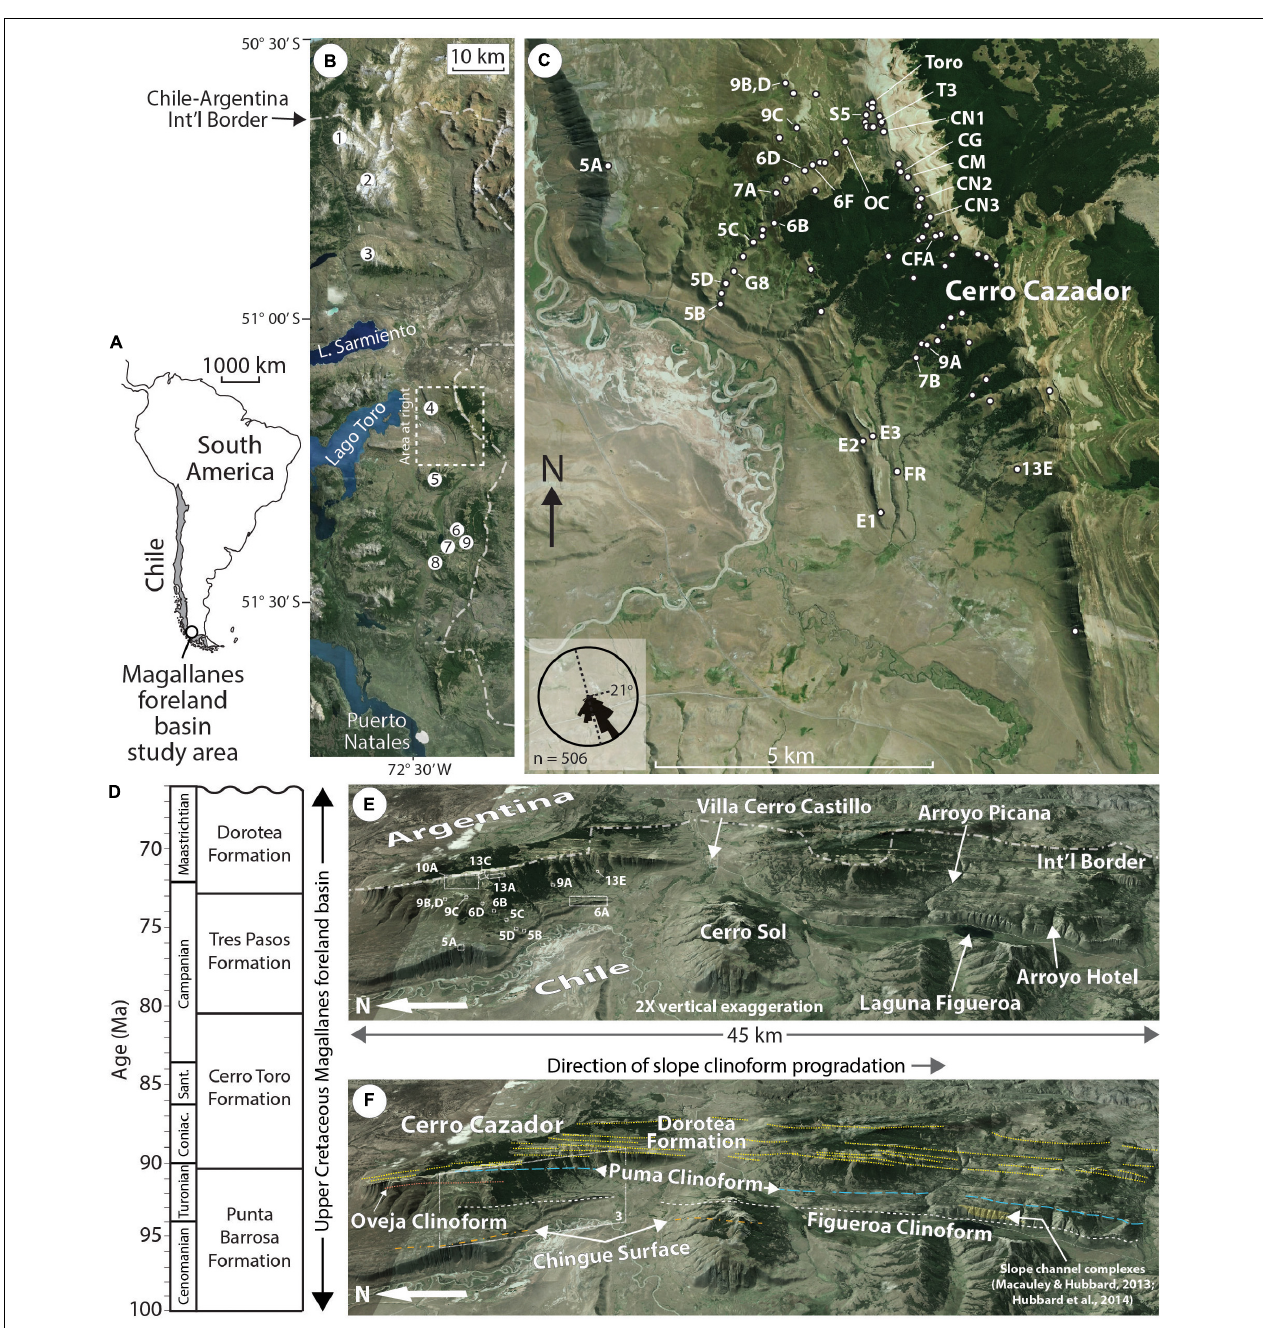
FIGURE 2 | Magallanes Basin stratigraphy and study context. (A) Continental-, (B) provincial- and (C) mountain- scale context for the study. Regional satellite image in (B) features previously studied Tres Pasos and Dorotea formation outcrops: (1) Cerro Divisadero, Romans et al., 2009; (2) Cerro Escondido, Covault et al., 2009; (3) Sierra Contreras, Armitage et al., 2009; (4) El Chingue Bluff, Shultz and Hubbard, 2005; (5) Cerro Sol, Hubbard et al., 2010; (6) Arroyo Picana, Pemberton et al., 2016; (7) Laguna Figueroa, Macauley and Hubbard, 2013; Hubbard et al., 2014; (8) Arroyo Hotel, Hubbard et al., 2010; and (9) Puma-Picana confluence, Reimchen et al., 2016. Paleoflow was orientated S-SE at 160 ◦ –170 ◦ on average, near parallel to the current structural orientation of the strata (strike = 165; dip = 21E) yielding a depositional dip perspective. White dots in (C) indicate outcrop locations studied. In instances where these are labeled with a preceding number, the label corresponds to the Figure number where this location is featured; labels with a preceding letter are locations that are featured within Figures. (D) Stratigraphic chart for the foreland basin in the vicinity of Cerro Cazador with the simplified stratigraphic architecture of the main lithostratigraphic units. The Tres Pasos and Dorotea formations are associated with the final fill of a long-lived deep-water seaway (modified from Daniels et al., 2019). (E) Eastward view of the area studied highlighting key geographical features and locations of areas featured in figures. (F) Same view as in Part (E) showing the stratigraphic framework of the area, featuring a dip-oriented cross-section of a high-relief clinoform system (cf. Figure 1 ). The Dorotea Formation consists of deltaic deposits whereas the underlying Tres Pasos Formation comprises genetically linked, southward-prograding clinoform strata. All satellite image data from Google, Landsat, Copernicus, 2016, http://google.com/earth/index.html.